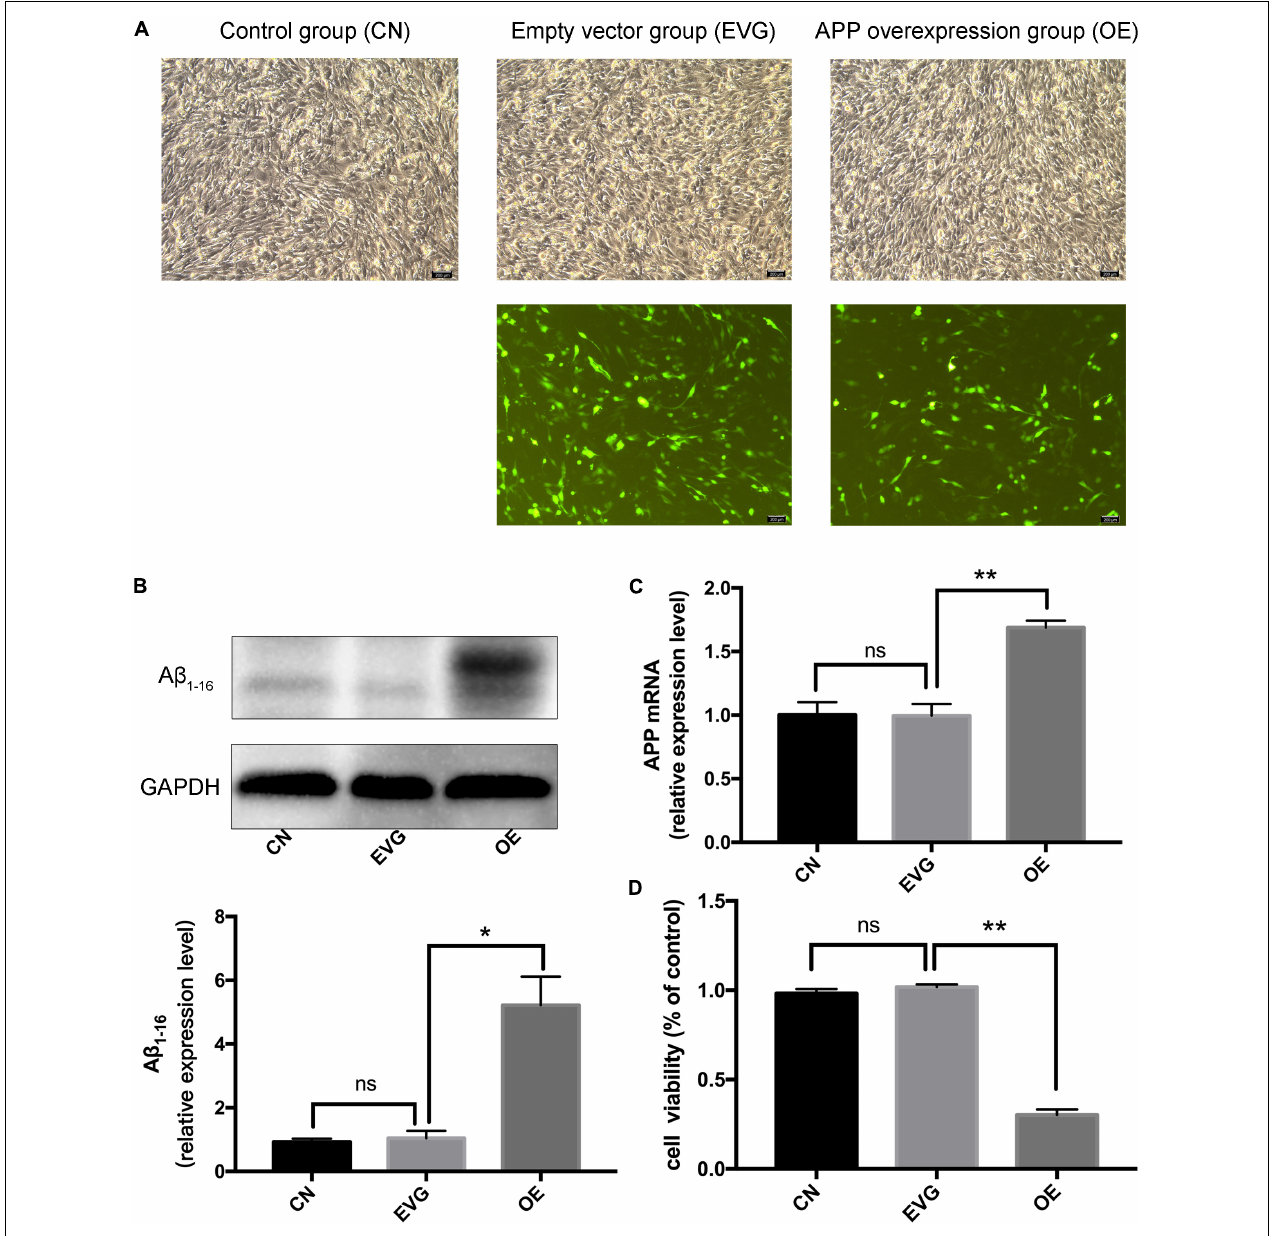
FIGURE 1 | The expression of APP and viability of PC-12 cells after transfection. CN denotes control group without special treatment; EVG denotes the empty vector group in which the PC-12 cells were transfected with empty vectors plasmid; while OE denotes the group in which the PC-12 cells were transfected with human APP plasmid. (A) Observation of the morphology of PC-12 cells transfected for 48 h by using a fluorescence inverted microscope. (B,C) The expression level of A β 1 - 16 protein and APP mRNA in PC-12 cells 48 h after transfection. (D) Cell viability of PC-12 cells 48 h after transfection. Compared with CN, ns p > 0.05. Compared with EVG, * p < 0.05, ** p < 0.01. One-way ANOVA with Bonferroni’s post hoc test. Scale bar = 200 µ m.